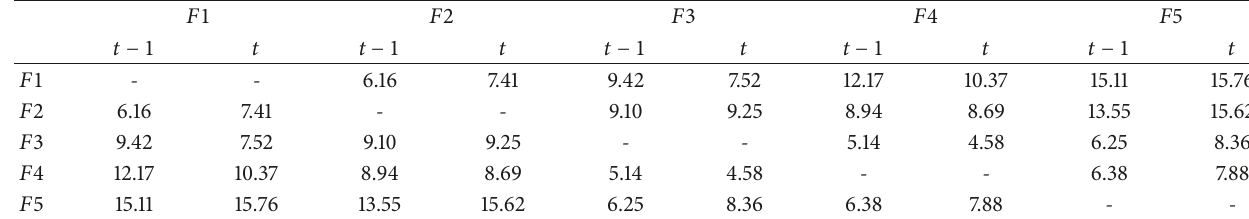
Table 1: Between-aircraft ellipsoid distances at the current and previous time points.